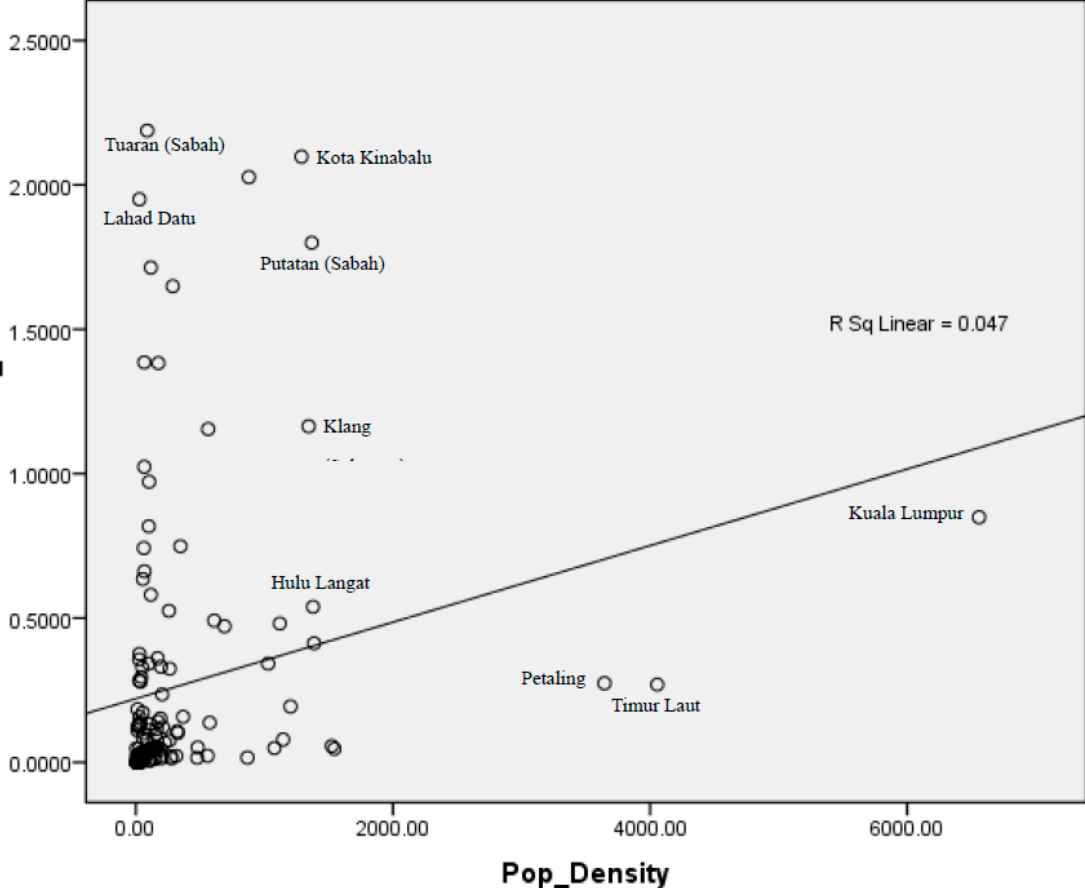
Table 6 . Summary of the results from both analytical models.